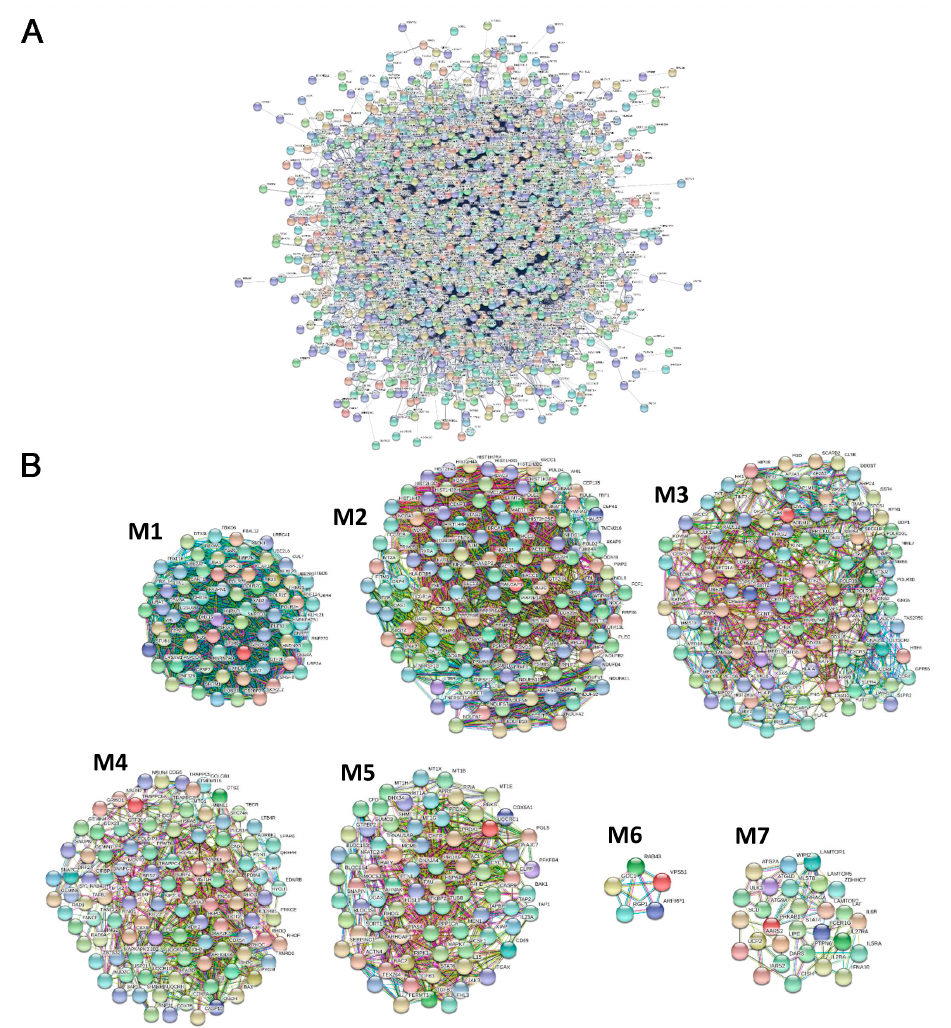
Figure 1. Network analysis of differentially expressed genes (DEGs) in pSjS patients. ( A ) Protein– protein interaction (PPI) network of DEGs; ( B ) Modules originated from the interaction network.